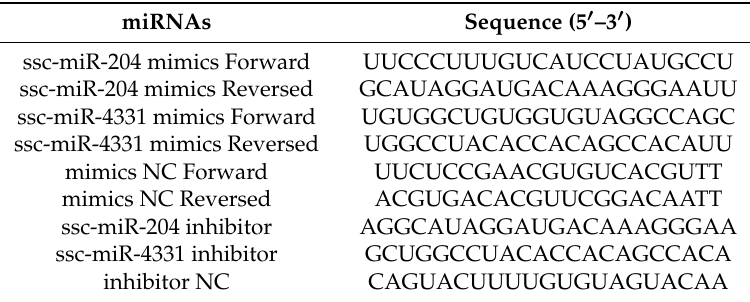
Table 4. The sequences of ssc-miR-204 and ssc-miR-4331 mimics and inhibitors. miRNAs Sequence (5 (cid:48) –3 (cid:48)